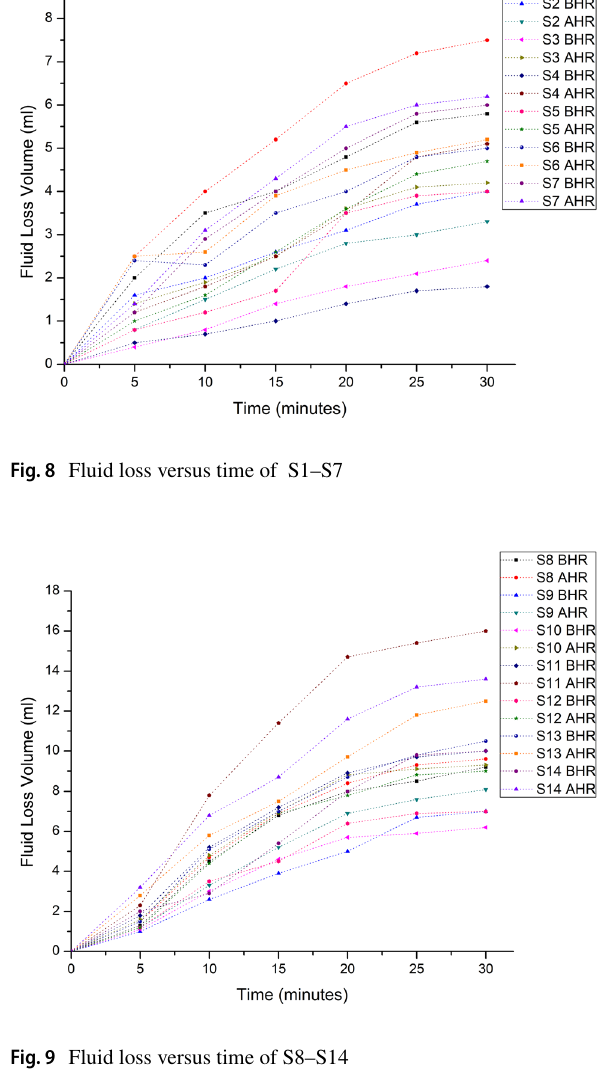
Fig. 9 Fluid loss versus time of